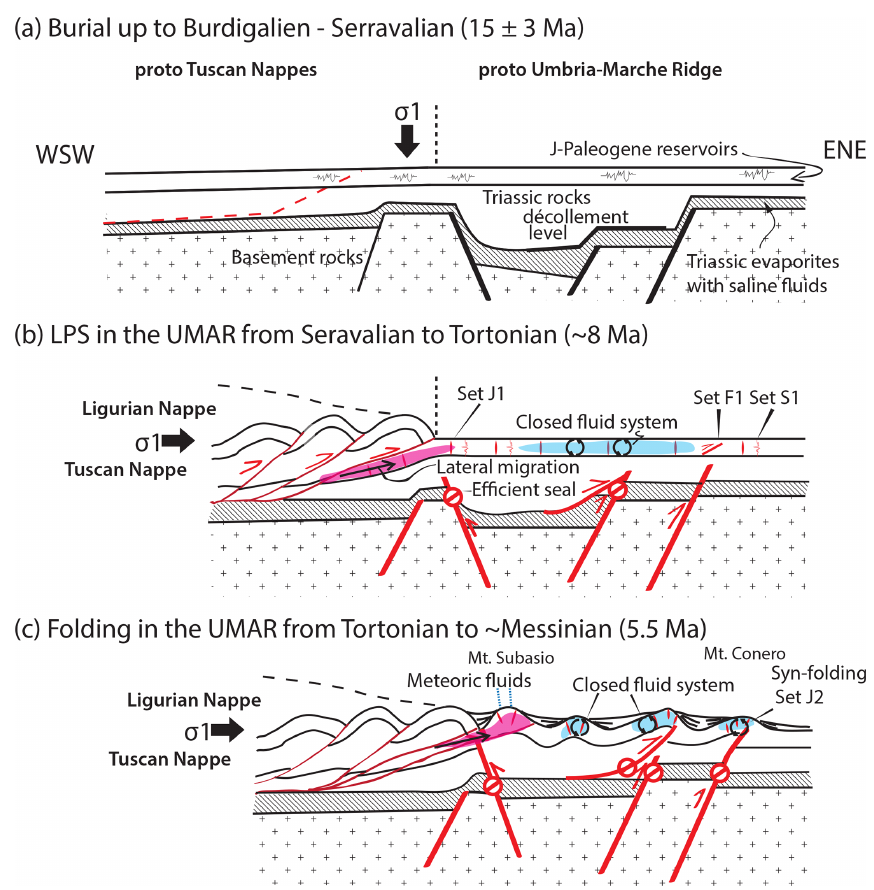
Figure 11. Conceptual model representing fracture development and regional-scale fluid migration during the formation of the Tuscan Nappes and Umbria–Marche Apennine Ridge. Red areas represent the extent of eastward pulses of hydrothermal fluids. Blue areas represent closed fluid system at the scale of the carbonate reservoirs. Potential effects of flexural event reported during upper Burdigalian and Lower Messinian in the eastern part of the belt (Mazzoli et al., 2002; Tavani et al., 2012) have not been documented in our dataset and, therefore, are not considered in this